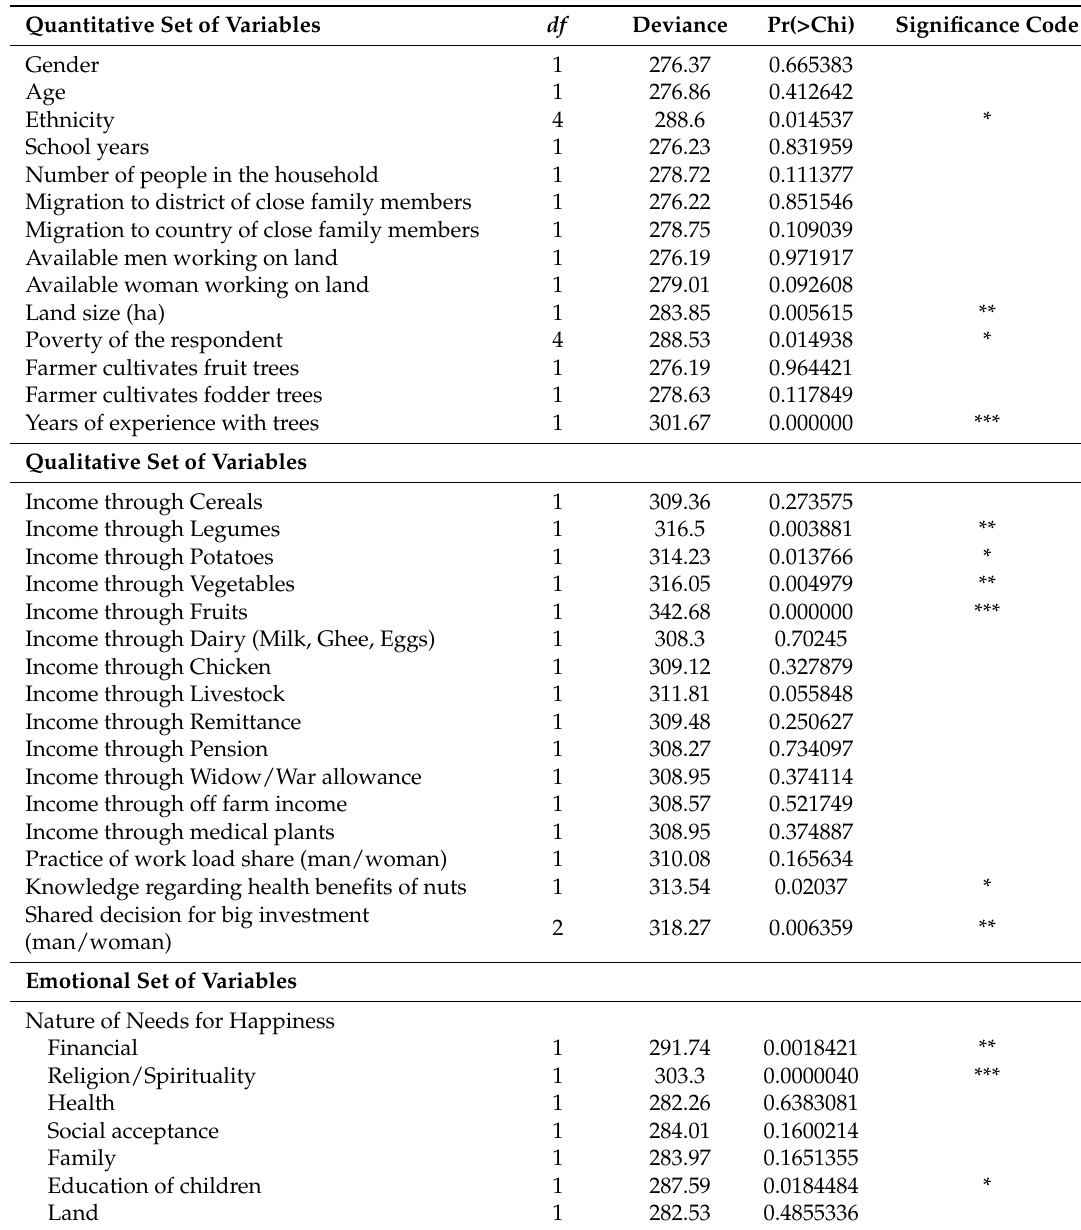
Table A1. Pre-result logistic regression after using command drop1 in R (ETH Zurich, Zurich,